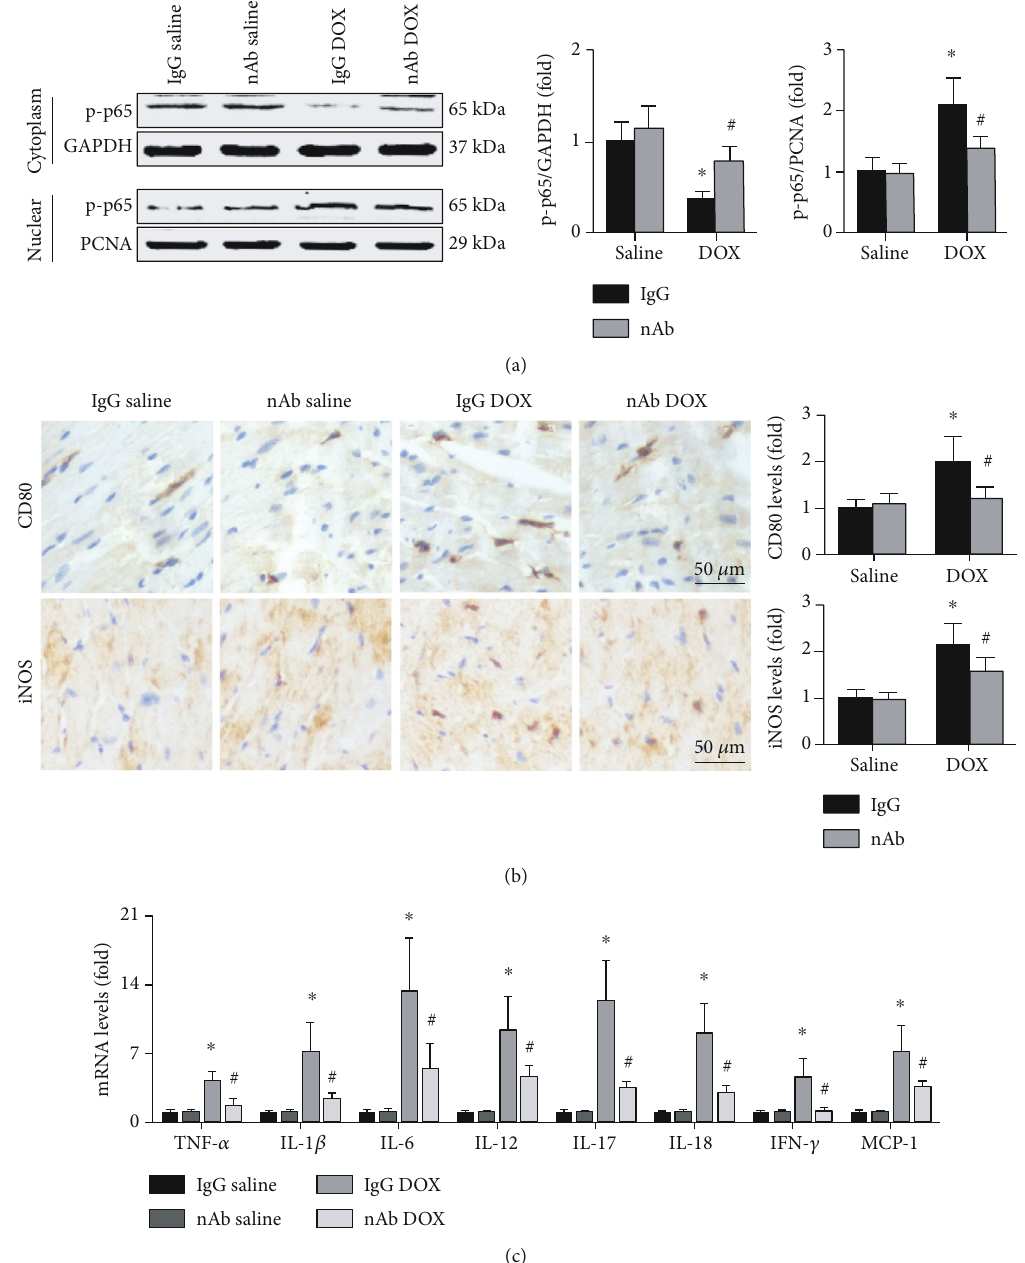
Figure 3: E ff ects of anti-IL-16 nAb on DOX-induced M1 macrophage di ff erentiation. (a) Protein expression of p-p65 in both the cytoplasm and nucleus was detected in the four groups (nonparametric test). (b) Cardiac expression of CD80 (brown granules) and iNOS (brown granules) was detected by immunohistochemical staining (200x, ANOVA). (c) Cardiac mRNA levels of TNF- α , IL-1 β , IL-6, IL-17, IL-18, IFN- γ , and MCP-1 were detected in each group by RT-qPCR (ANOVA). N = 5 for each group. ∗ p < 0 : 05 vs. the IgG saline group. # p < 0 : 05 vs. the IgG DOX